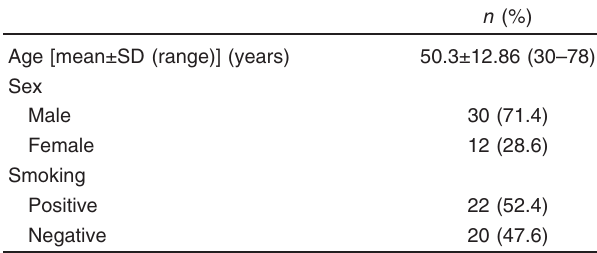
Table 2 Descriptive characteristics of the involved patients